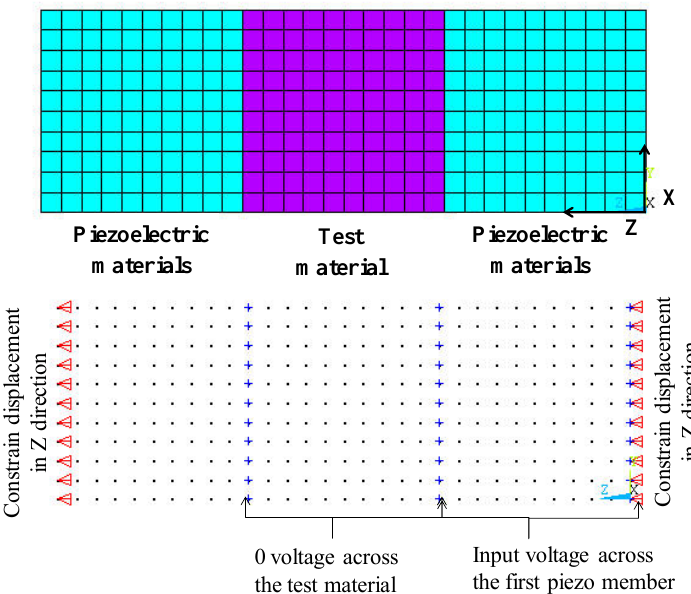
Figure 2. Finite element model of the strain sensing system where the piezoelectric segments have cross-sectional areas equivalent to the test segment, with loads and constraints